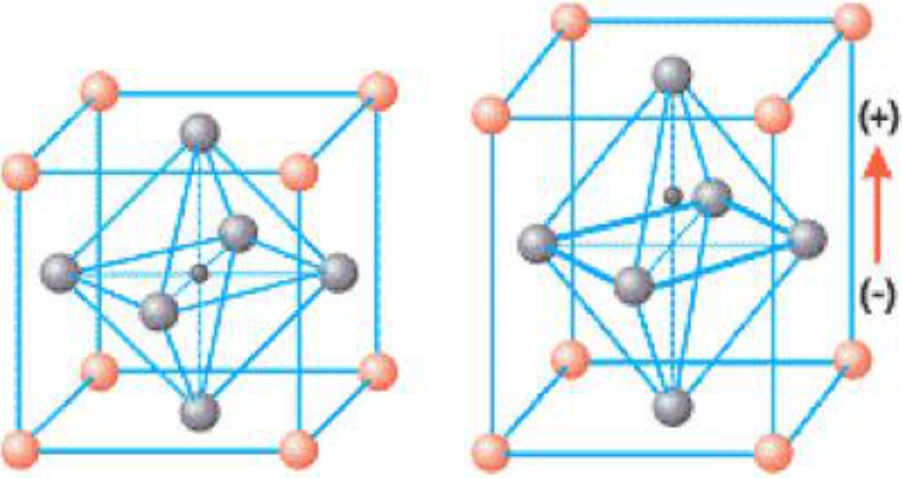
Figure 8. The crystal structure of PZT. The red spheres are lead (Pb), the gray spheres are oxygen and the small black sphere in the center is titanium (Ti) or zirconium (Zr). When an electric field is applied, the crystal elongates by about 0.1% (shown on the right). The stoichiometry is Pb[Zr x Ti 1-x ]O 3 with ( 0 ≤ x ≤ 1 ) . Figures used with permission from American Piezo ® , Inc. [43]. Since the unpoled ceramic material we are using is comprised of micron-scale crystal- lites (i.e., single crystals), these crystallites are oriented at random. When an electric